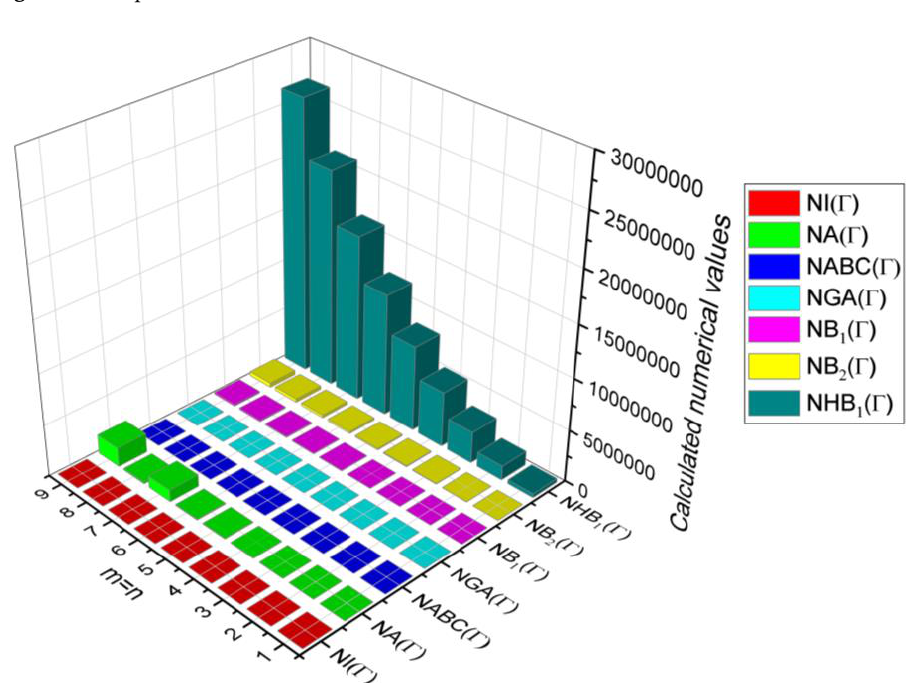
Figure 15. 3D plots for Table 13.